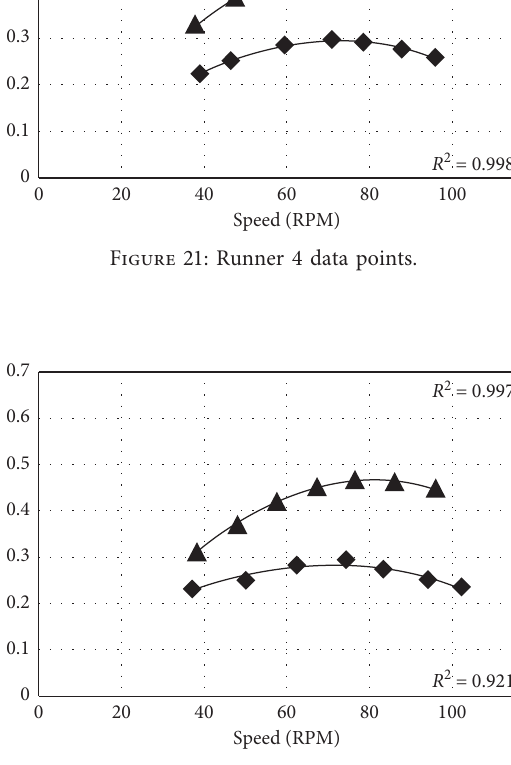
Figure 22: Runner 5 data points.